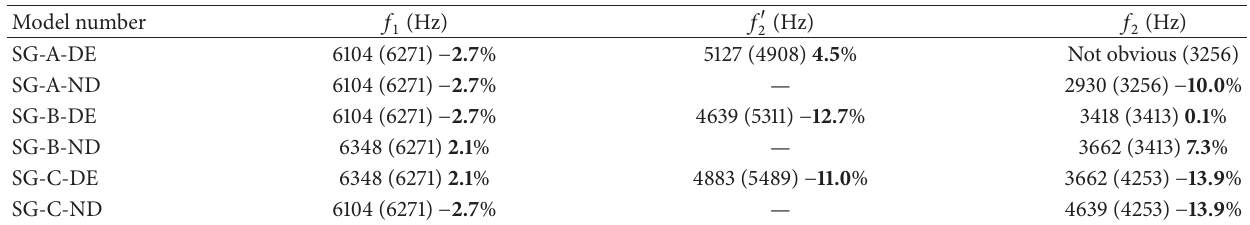
Figure 10: Acceleration-time curves of SG-A without surface waves. Table 5: Comparison of peak frequency between finite element simulation and theoretical